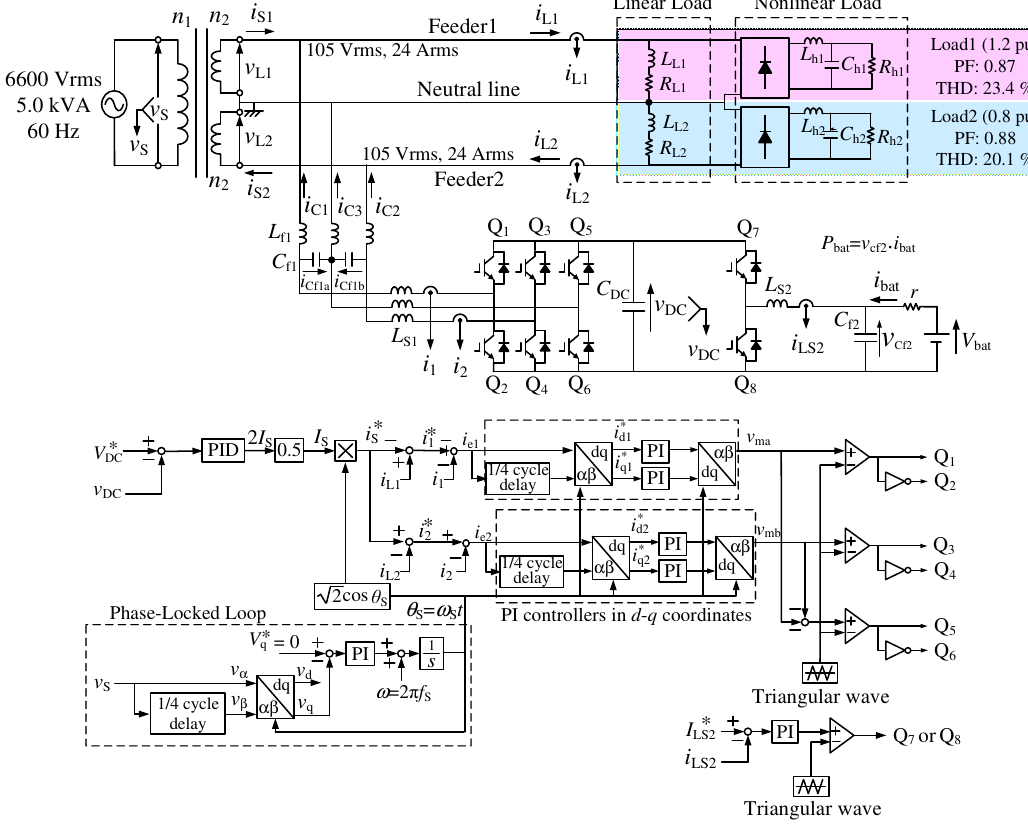
Figure 4. Circuit diagram of proposed smart charger for EVs with nonlinear loads in